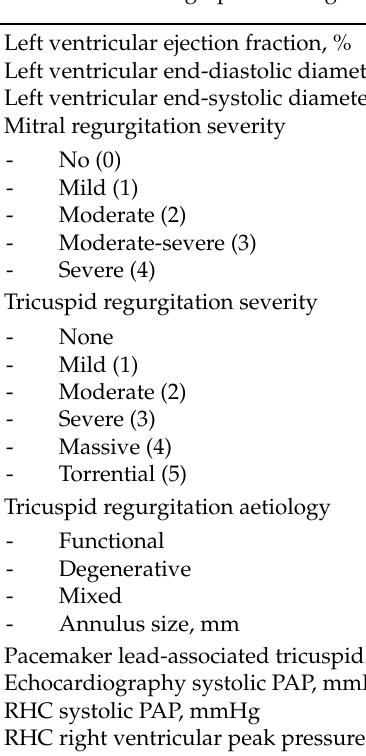
Table 2. Echocardiographic and right heart catheterization characteristics.